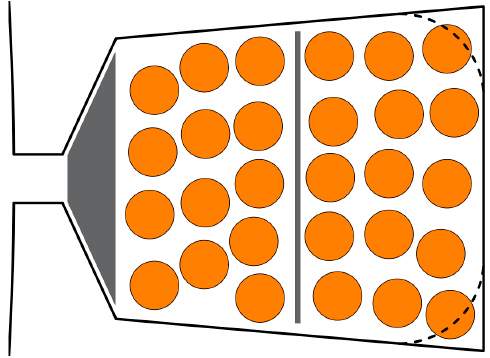
Figure 2. Detail of the slot.